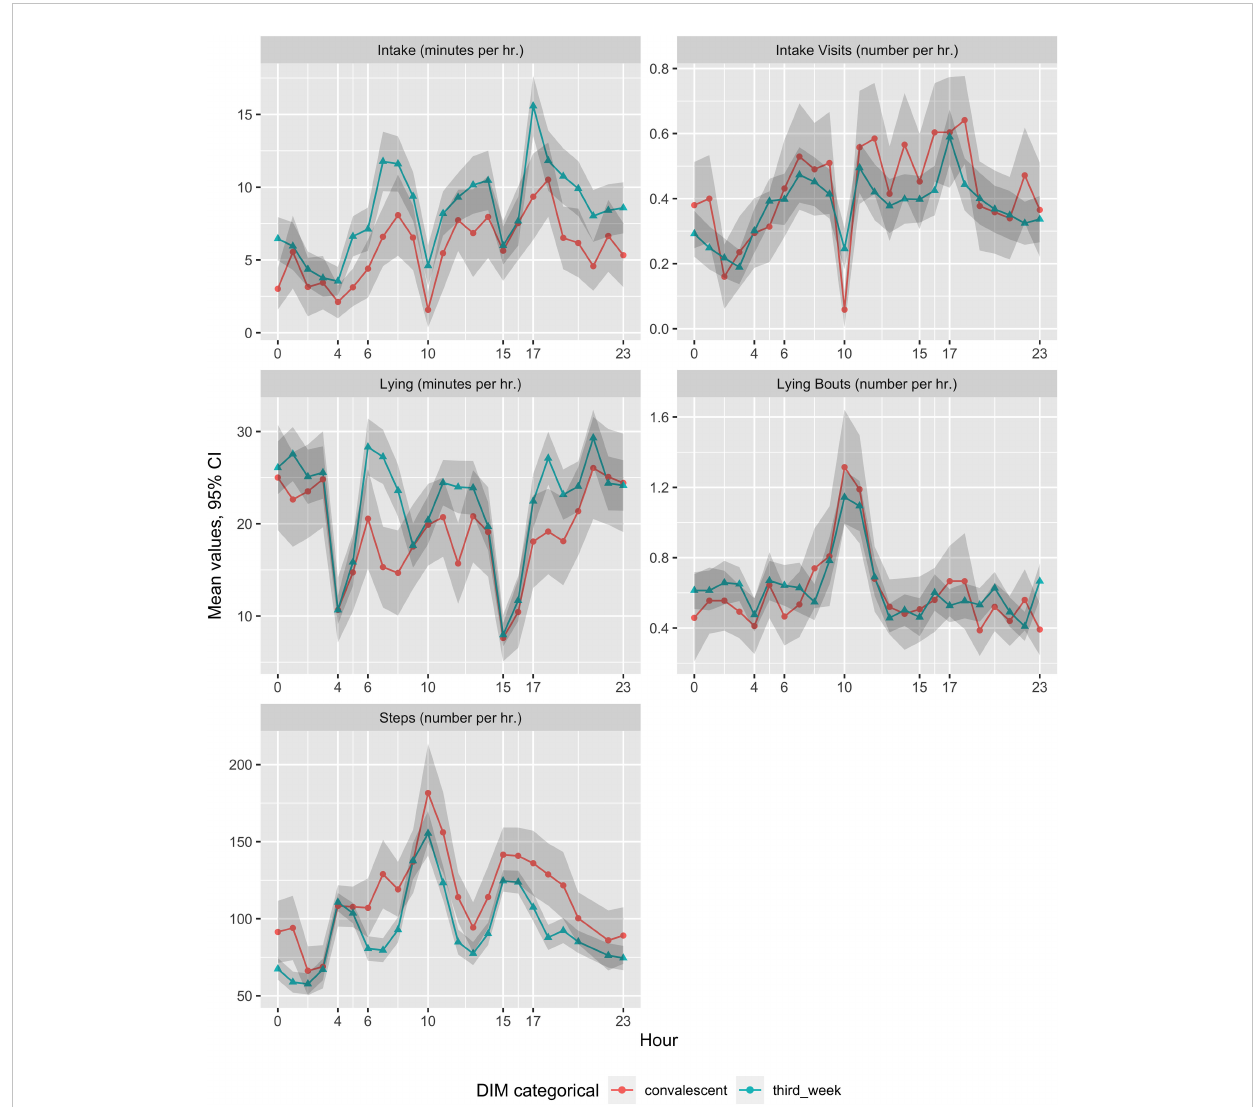
FIGURE 4 Mean raw sensor data and 95% C.I. for the mean for each behavioral variable measured with a leg-attached 3-axis accelerometer (TrackaCow, ENGS, Hampshire, UK) in a 24-hour period strati fi ed by parity and days in milk (DIM) categorized as convalescent (parturition to 3 DIM), fi rst week (4 – 7 DIM), second week (8 – 14 DIM), and third week (15 – 21 DIM). Only convalescent and third week are shown for comparison